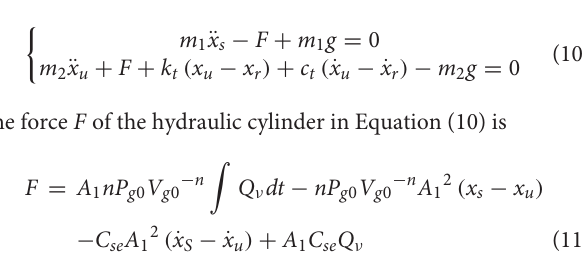
indicates that the hydro-pneumatic spring is compressed. The symbolic function sgn ( x ) in Equation (7) (x) is defined